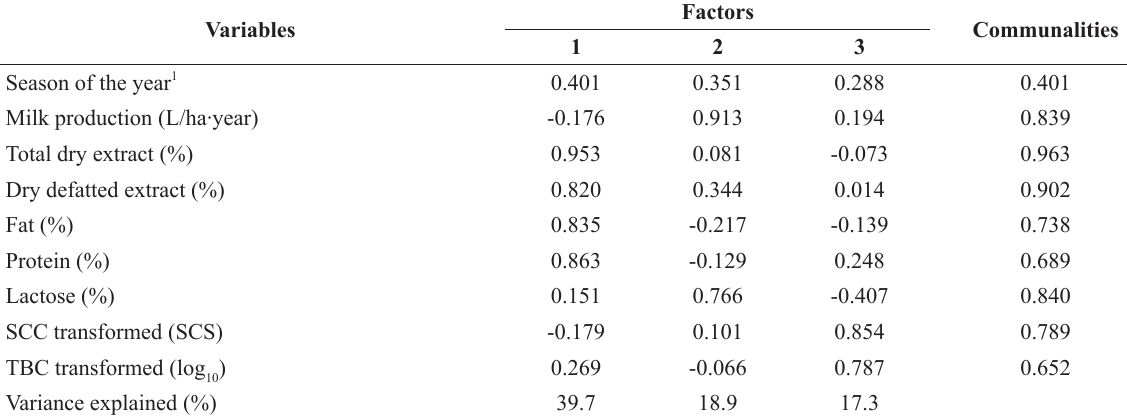
Factorial loadings, eigenvalue, percentage of variance and commonality of each variable that composes the factorial analysis of milk production and composition data according to the seasons of the year, microbiological quality of milk and health of the mammary